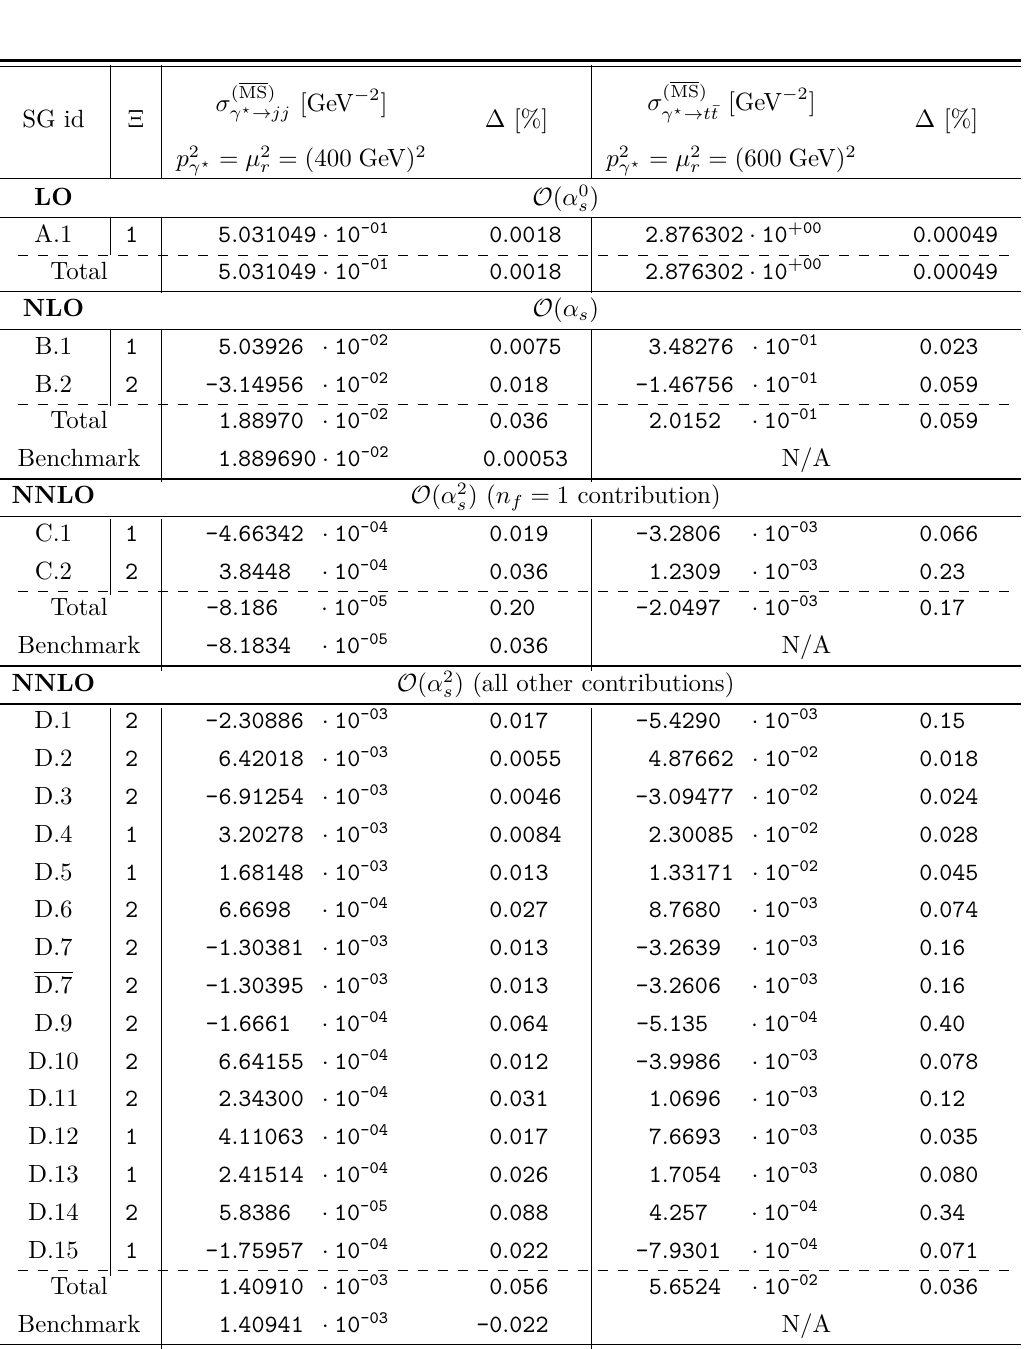
= 1 and Q = 1 / 3 f q